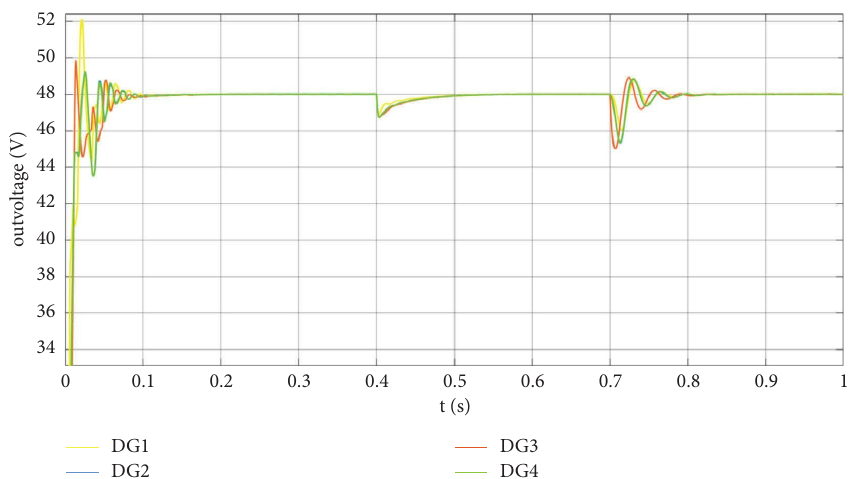
Figure 13: Output voltage with the proposed